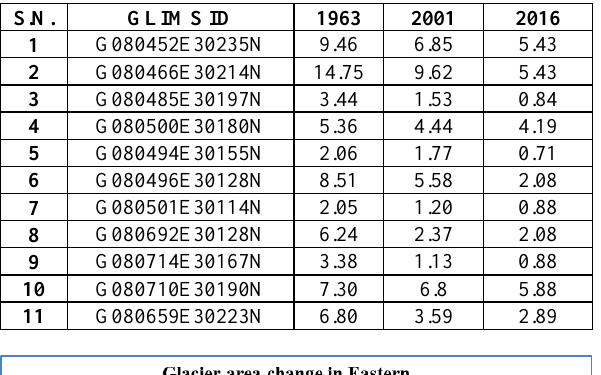
Table: 1 Glacier area change during 1963-2016 (area in Sq.km).